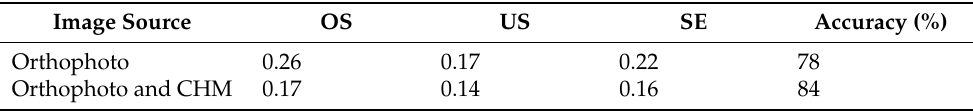
Figure 4. Visual comparison of segmentation using orthophoto alone vs. orthophoto with CHM at highlighted sites 1–3: ( a ) Original orthophoto; ( b ) using only the orthophoto, over-segmentation and with irregular outlines for tree crowns; and ( c ) using orthophoto and CHM, tree crowns are well segmented with smoother outlines.